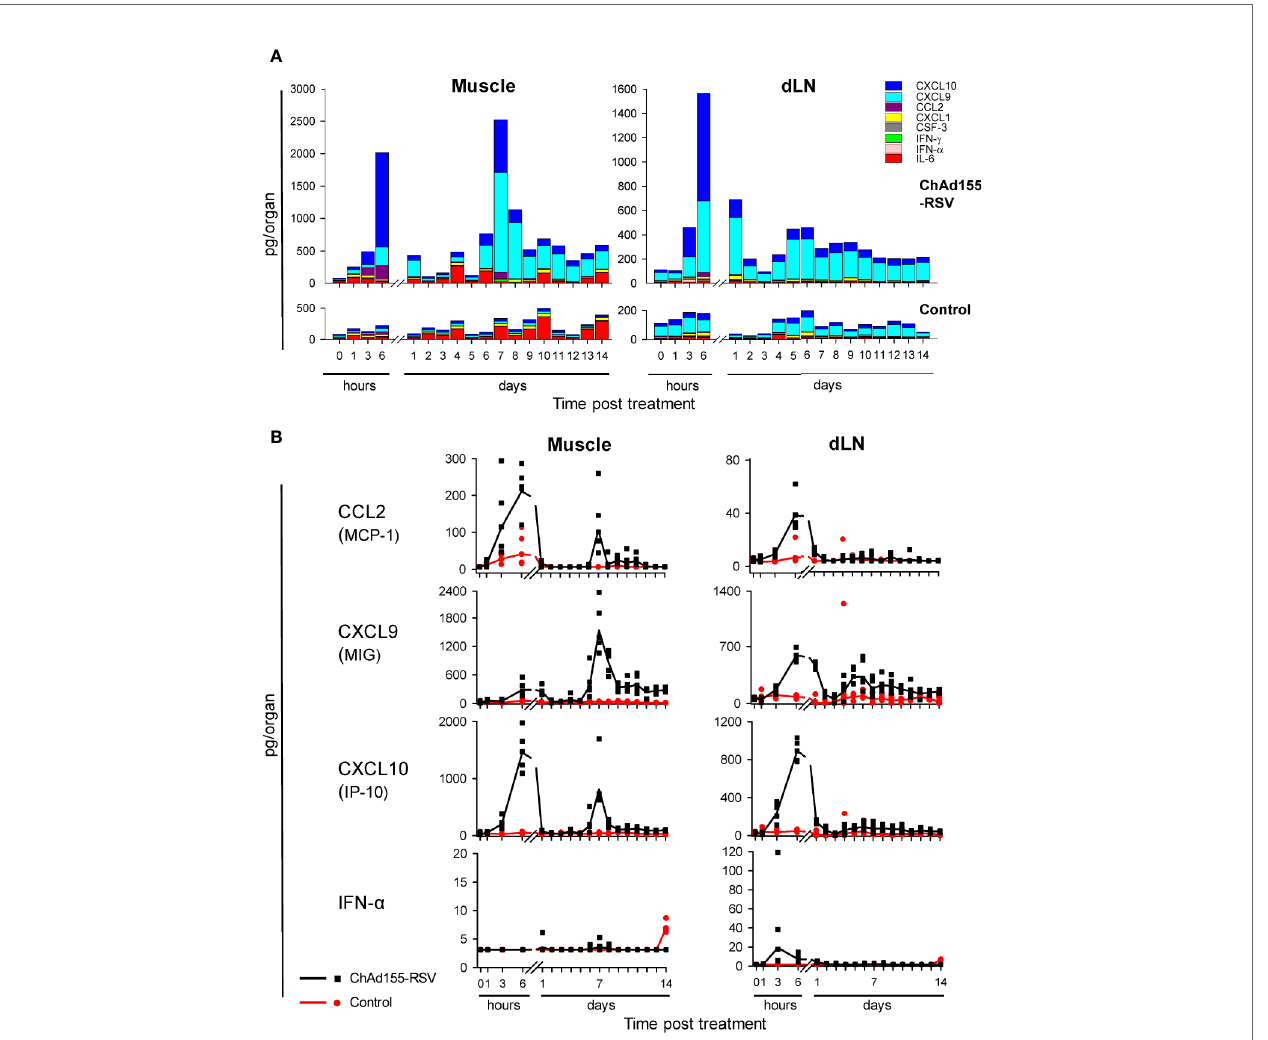
FIGURE 2 | Local cytokine responses in mice are dominated by CXCL10 and CXCL9. Cytokine responses in homogenates of the injected muscles and draining lymph nodes (dLN) collected from mice treated with ChAd155-RSV (10 8 vp) or buffer ( “ Control ” ) are shown (n = 5/group/time point). Injections (10 µl) were performed unilaterally in the left gastrocnemius muscle at Day 0. Tissues were collected before immunization (0 h), and after immunization at 1, 3, and 6 h, and then daily from 24 h (Day 1) through Day 14. Graphs represent data from a single experiment. Cytokine levels (expressed in pg/organ) were detected in homogenate supernatants of the indicated tissues collected from the injected side of each animal. Geometric mean concentrations are presented as cumulative bars (A) or lines (B) . Each symbol in (B) represents one